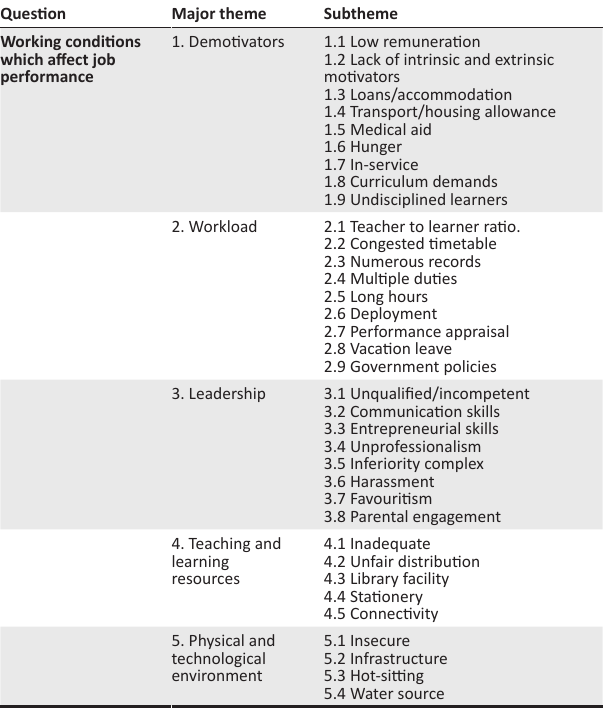
TABLE 2 : Research question and generated main and subthemes.